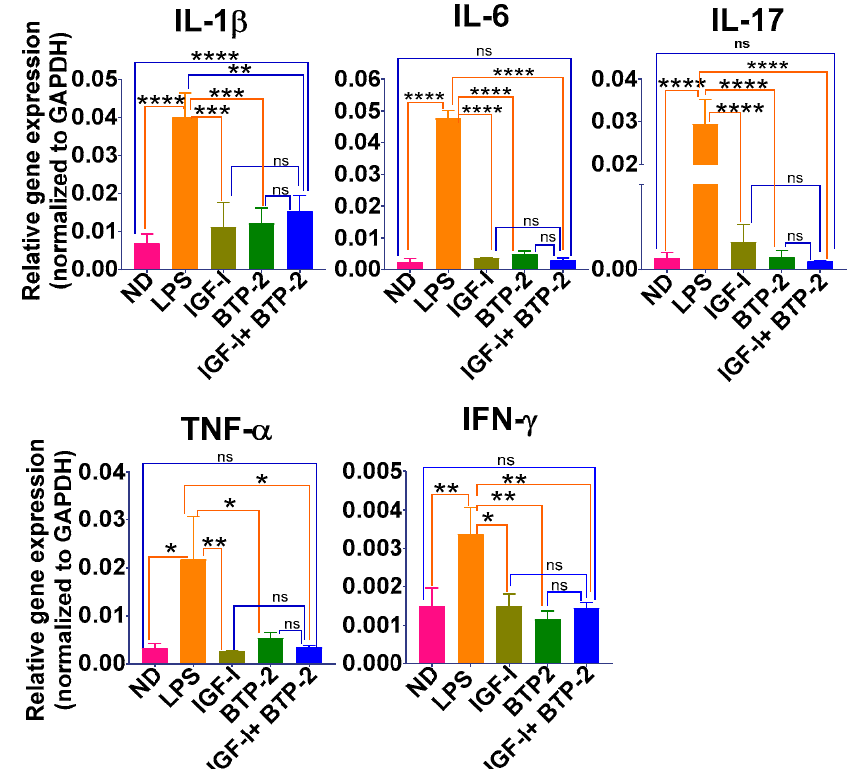
Figure 3. Effects of IGF—I, BTP—2 monotherapies, and IGF—I + BTP—2 combination therapies on the major proinflammatory cytokines in the lungs. Day 7 RT—qPCR of the markers IL—1 β , IL—6, IL—17, TNF— α , and IFN— γ . Data are the mean ± SEM. * p < 0.05, ** p < 0.01, *** p < 0.001, and ****